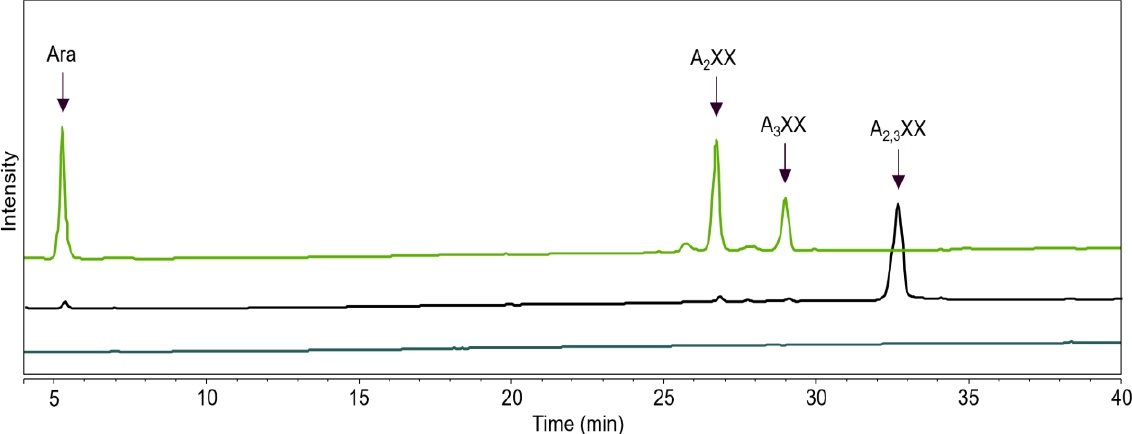
Figure 6. HPAEC profiles of A 2,3 XX (xylotriose disubstituted on the non-reducing end) incubated with Hi ABF43_36a (green), without enzyme (substrate blank) (black), and with Hi ABF43_36a but without substrate (enzyme blank) (dark green). Incubation contained 1 µ g mL − 1 enzyme and 100 µ g mL − 1 A 2,3 XX. Reaction conditions are displayed in Section 4.2.2, exp. # 2.